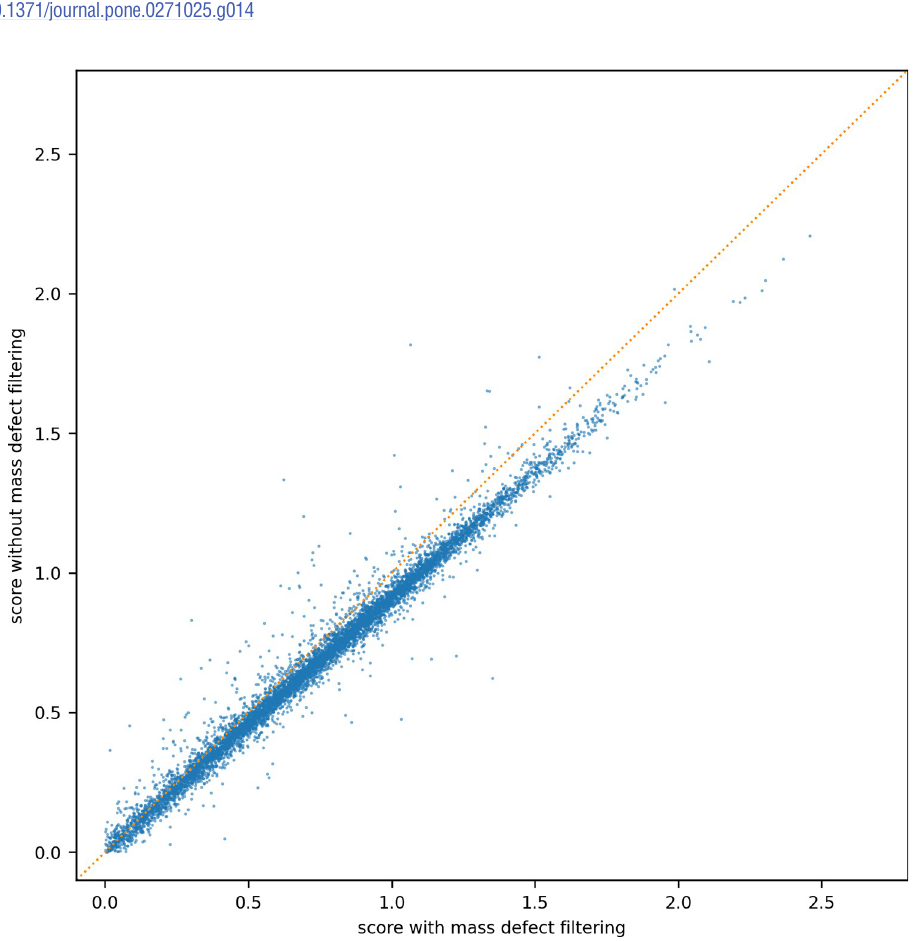
Fig 15. Comparison of the score from percolator for identified features with and without mass defect window filtering.